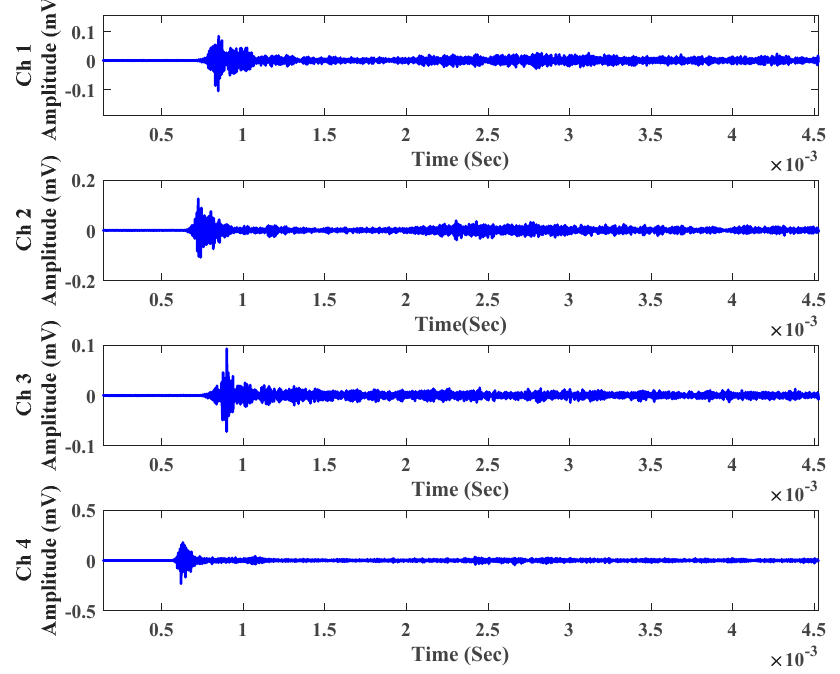
Figure 13. Acoustic emission signals obtained from the pencil lead break test (PLB) 2.